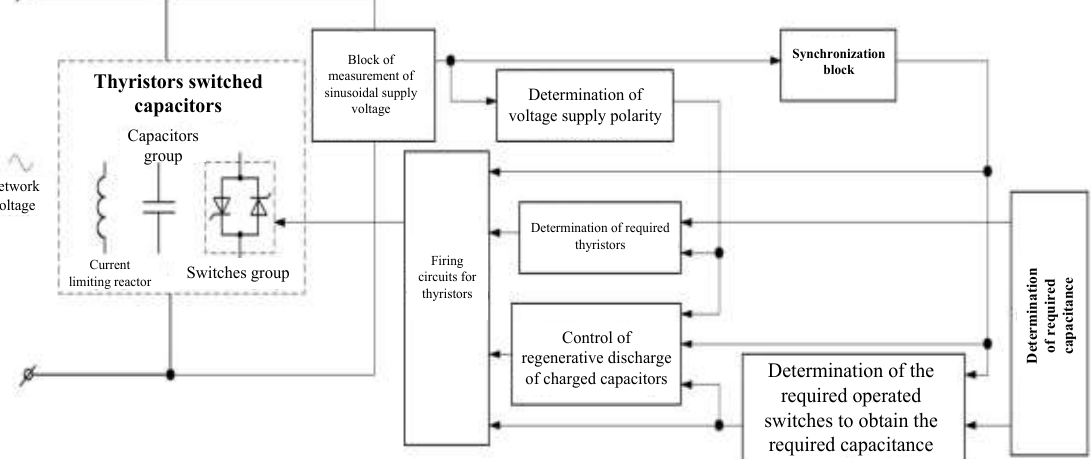
Fig. 9. Block diagram of new topology of TSC control system